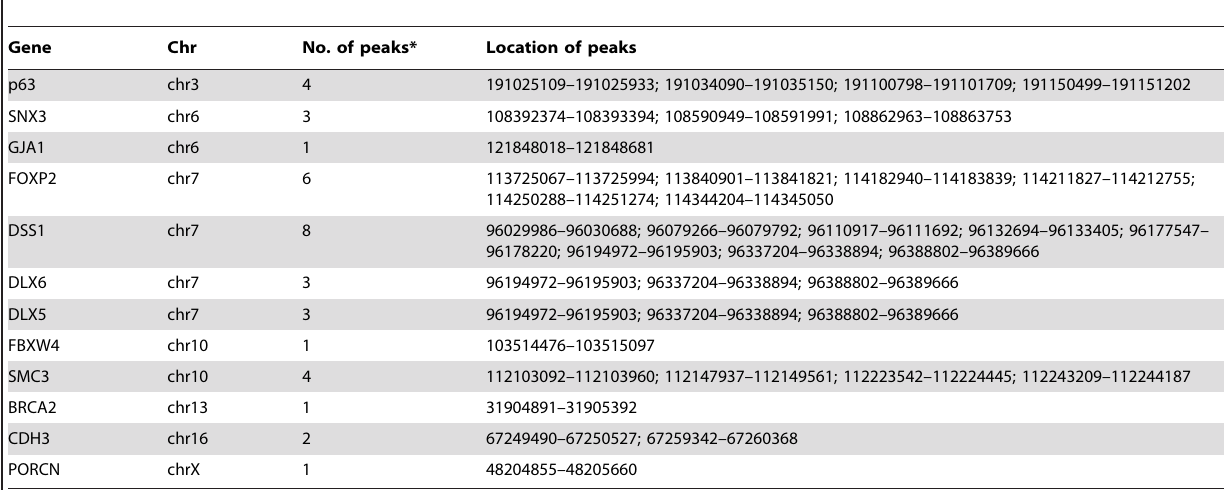
Table 2. p63-binding sites in the chromosomal regions near SHFM-associated genes (hg 18).